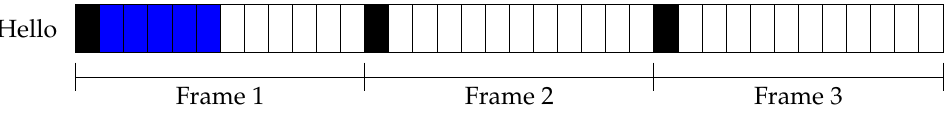
Figure 7. Example of